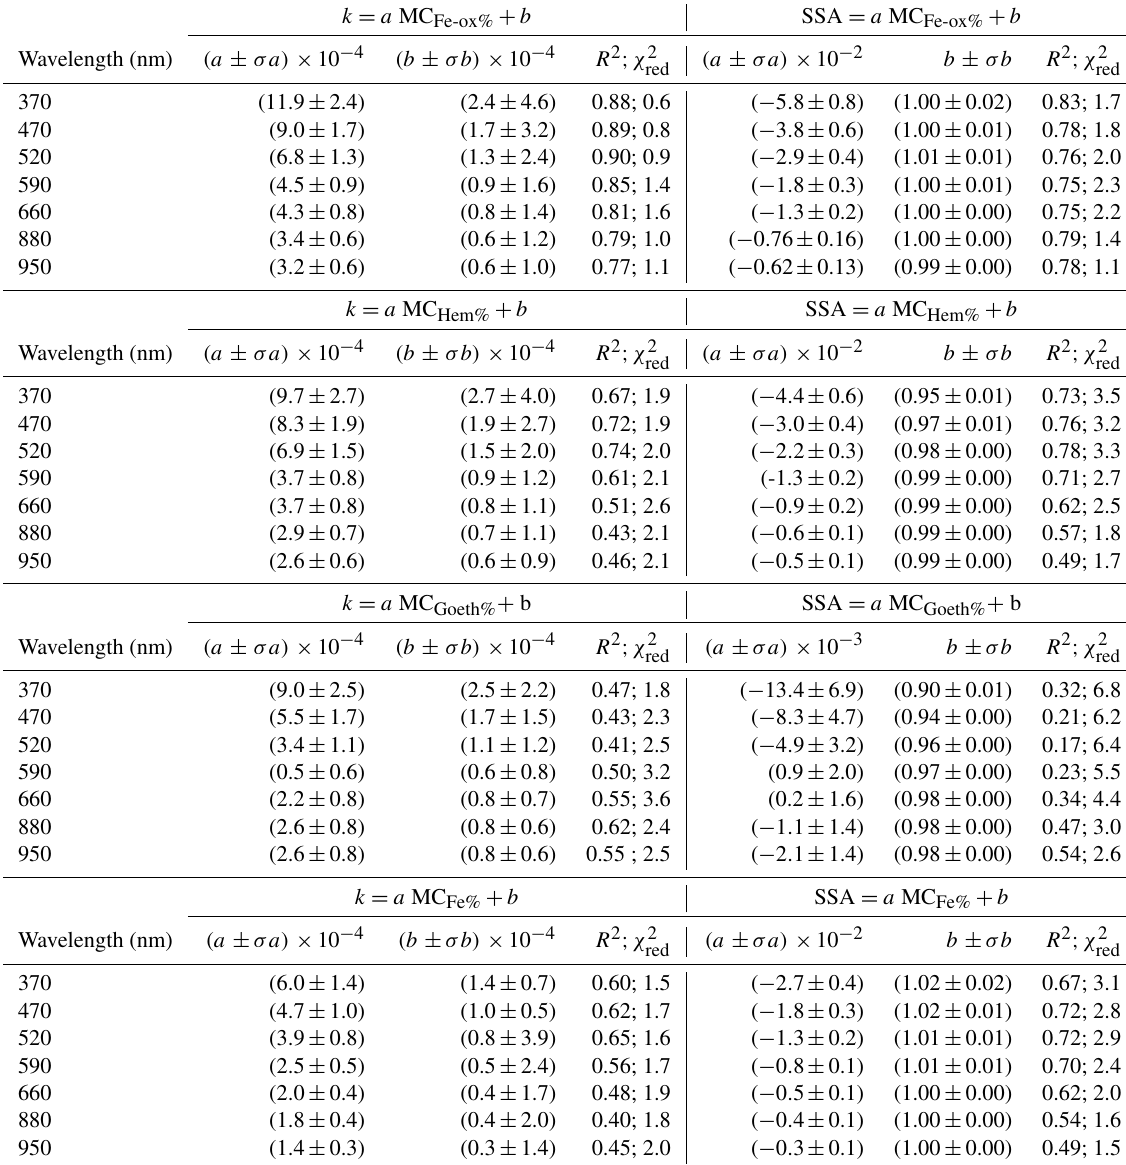
Table 6. Results of the linear fit between k , SSA, and the mass concentration of iron oxides (MC Fe-ox% ), hematite (MC Hem% ), goethite (MC Goeth% ), and elemental iron (MC Fe% ) in dust. Column 1 indicates the wavelength; ( a ± σa ) indicates the retrieved slope and its estimated uncertainty; ( b ± σb ) indicates the retrieved intercept and its estimated uncertainty; R 2 denotes the correlation coefficient; and χ 2 reduced chi square of the